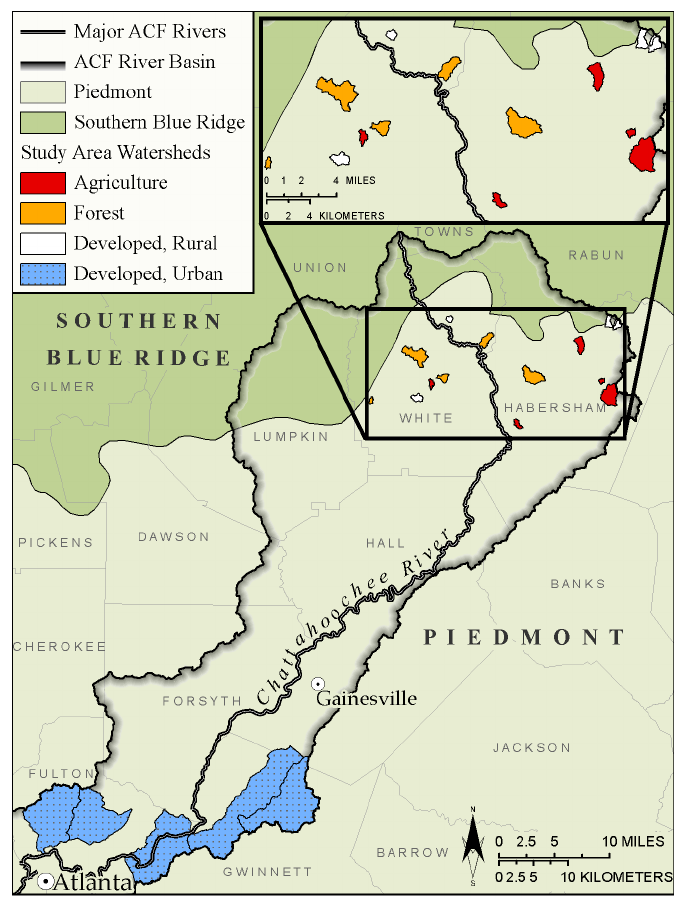
Figure 2. Map of 20 study area watersheds: five agriculture, five forest, five rural developed, and five urban